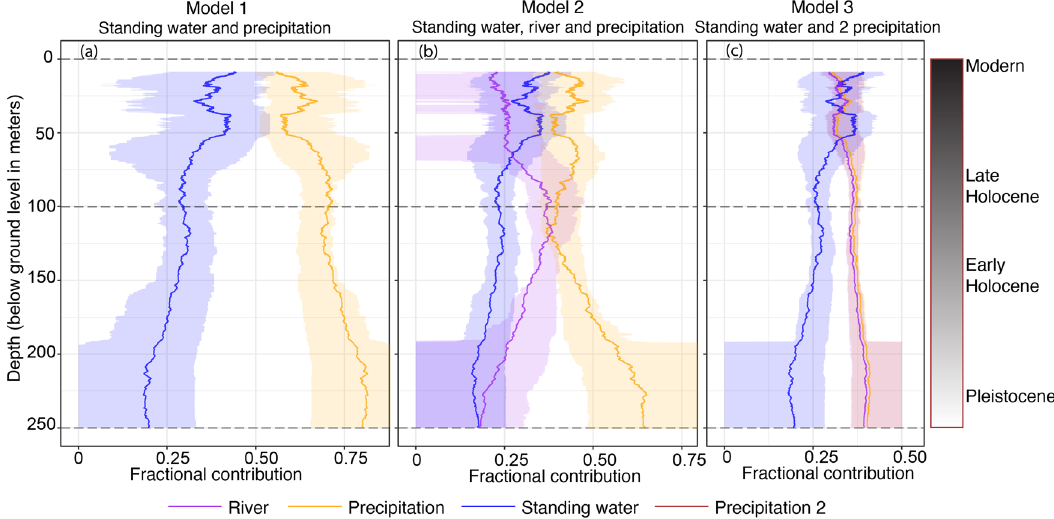
Fig. 7 Proportional contribution of large rivers, surface water, and precipitation sources versus depth. ( a ) Model 1, ( b ) model 2, and ( c ) model 3. The purple, blue, and orange lines are the moving depth average of 200 groundwater samples. The purple, blue, and orange-shaded regions are the corresponding interquartile range. The standard error associated with the moving depth average is less than <0.03, and for this purpose, clarity has been omitted from the fi gure. The dashed gray line at 100 m roughly differentiates between modern and late Holocene recharged water (0 – 100 m depth) with early Holocene and Pleistocene water (100 – 250 m depth). Please refer to Fig. S5 for the full statistical distribution of standing water for model 2.